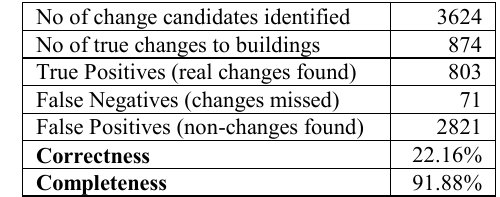
Table 1. Statistics of the results of the urban production